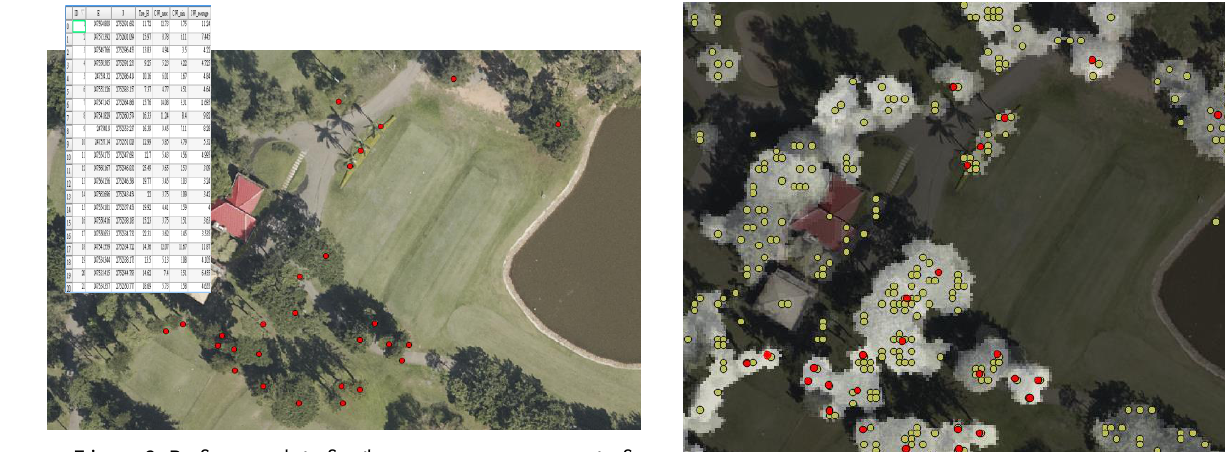
Figure 3. Reference data for the accuracy assessment of